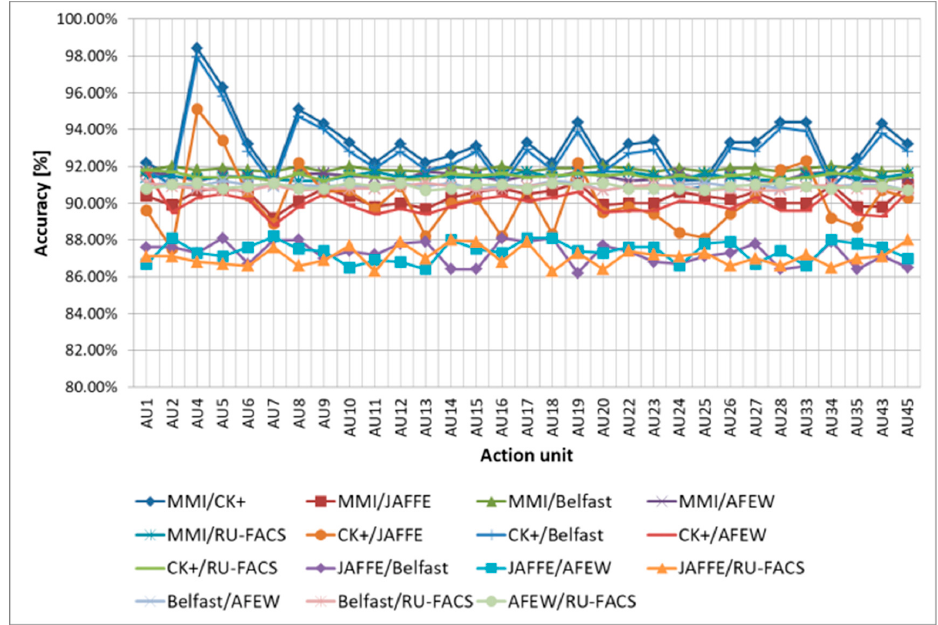
Figure 2. AU classification accuracy for cross-database tests.